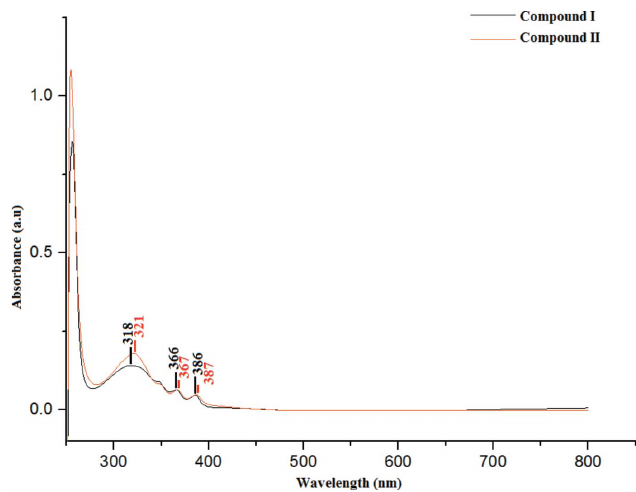
Figure 4 UV–Vis absorption spectra for compounds (I) and (II).